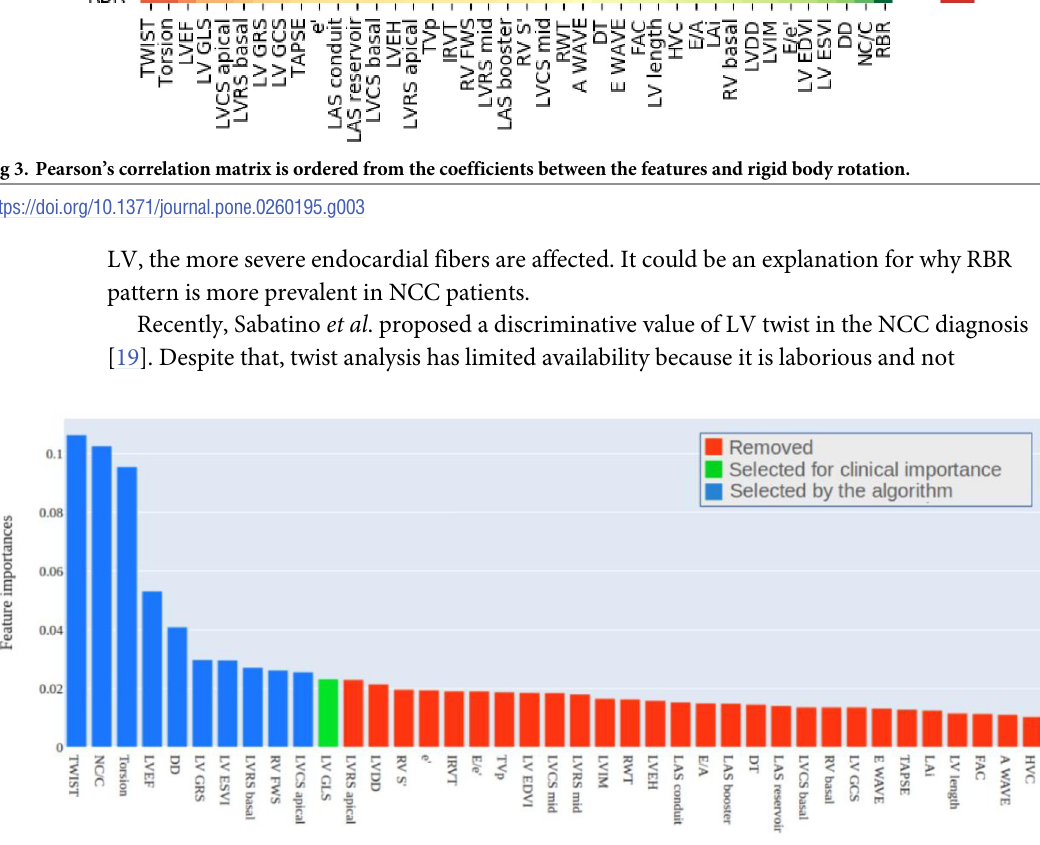
Fig 4. Echocardiographic features in decreasing order of importance to rigid body rotation in noncompaction cardiomyopathy